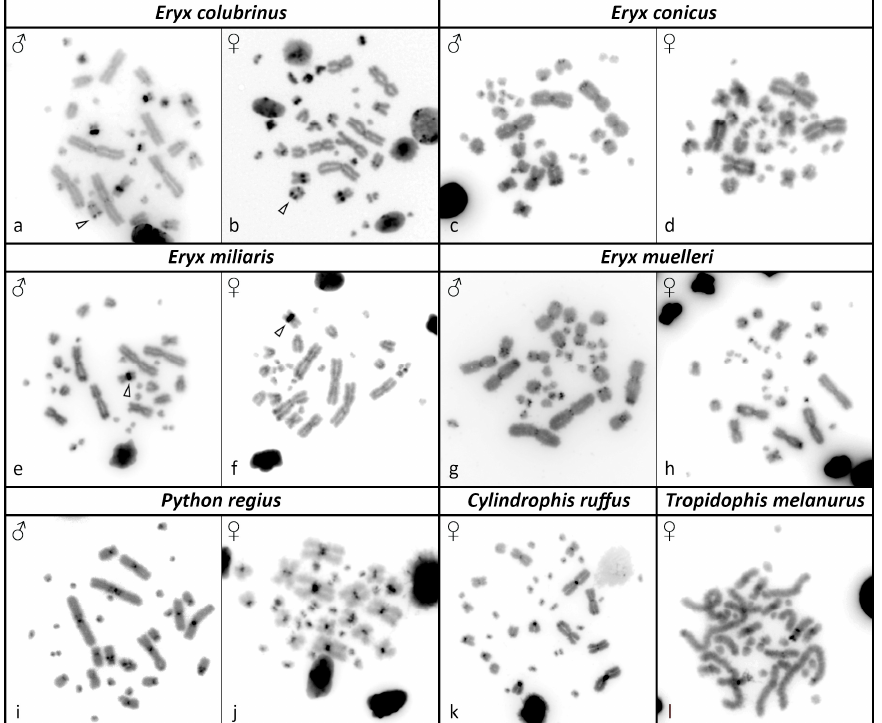
Figure 2. C-banded metaphases for the species: ( a , b ) Eryx colubrinus , ( c , d ) Eryx conicus , ( e , f ) Eryx miliaris , ( g , h ) Eryx muelleri , ( i , j ) Python regius , ( k ) Cylindrophis ruffus , and ( l ) Tropidophis melanurus . Chromosomes with polymorphism in heterochromatic blocks are indicated by arrowheads. Sex is indicated.